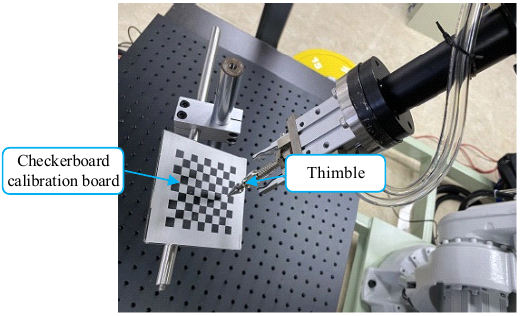
Figure 14. Reprojection error: ( a ) X coordinate reprojection error; ( b ) Y coordinate reprojection error; ( c ) Z coordinate reprojection error.